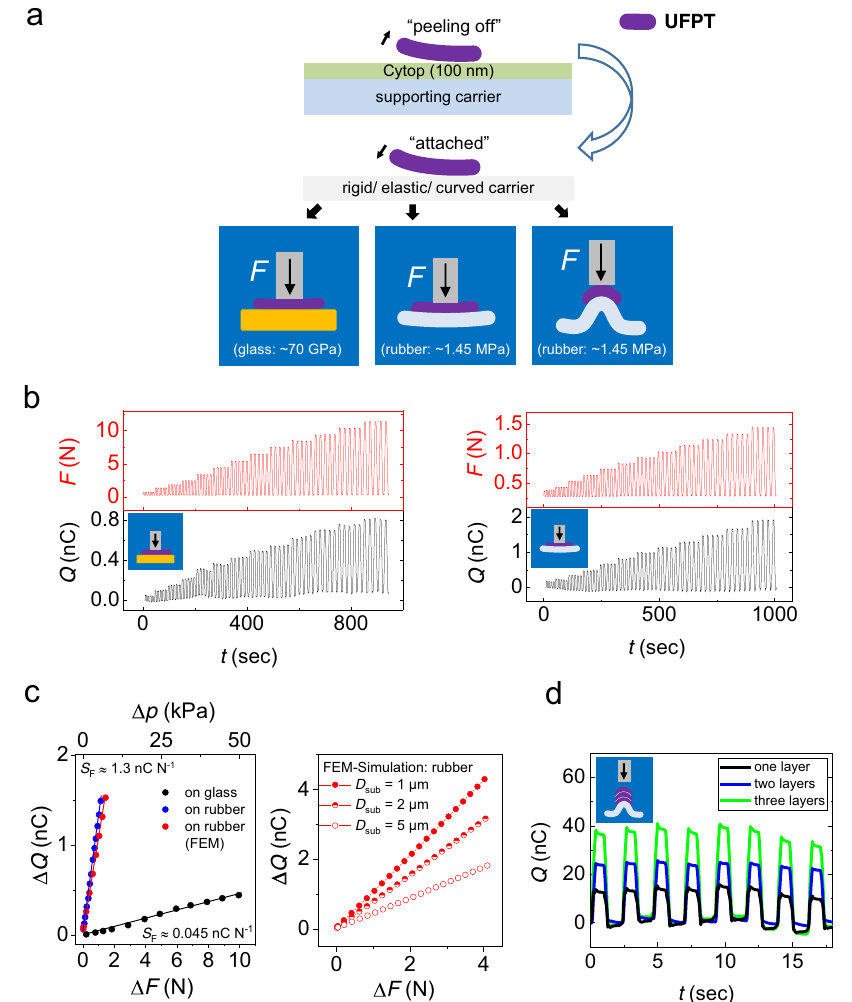
Fig. 3 Transversal-load test on different carrier substrates. a During fabrication, UFPT fi lms are fi xed on a supporting glass carrier. Later, the UFPT fi lms can be easily peeled off the supporting glass carrier and applied to various carriers with different structure, shapes, curvatures or material mechanic properties. To perform transversal-load testing, the UFPTs were applied to one of two types of carriers: a 1-mm-thick rigid fl at glass carrier (Young modulus Y ~70 GPa) or a 6-mm-thick elastic silicone rubber carrier ( Y ~1.45 MPa). A stamp attached to a piston exerted a periodic step-like transversal force F onto the UFPTs in three different setups, namely, for the rigid fl at glass carrier and for the elastic silicone rubber carrier in fl at or in pre-bent curved shape, which resulted in three different excitation schemes. b The charge response of a single transducer layer attached to the fl at glass carrier for transversal peak loads ranging between 0.25 N and 10.25 N (left) and to the fl at silicone rubber carrier for peak transversal loads ranging between 0.25 N and 1.25 N (right). The small baseline fl uctuation is stemming from charges generated by thermal fl uctuations. c The charge response of the transducer for glass and silicone rubber carriers from ( b ), plotted as a function of the applied force and pressure differences Δ F and Δ p , respectively. From the strictly linear relation Δ Q ( Δ F ) (and also Δ Q ( Δ p )), a sensitivity value S F can extract as the slope of the regression line (generated by linear least square fi ts). The results of the FEM simulations of the charge response to transversal loading for UFPTs with three different parylene substrate thicknesses D sub on rubber carriers are shown on the right. d Charge response of one, two and three piezoelectric transducer layers attached to a pre-bent (curved) rubber carrier under repetitive transversal loading of Δ F = 2.5